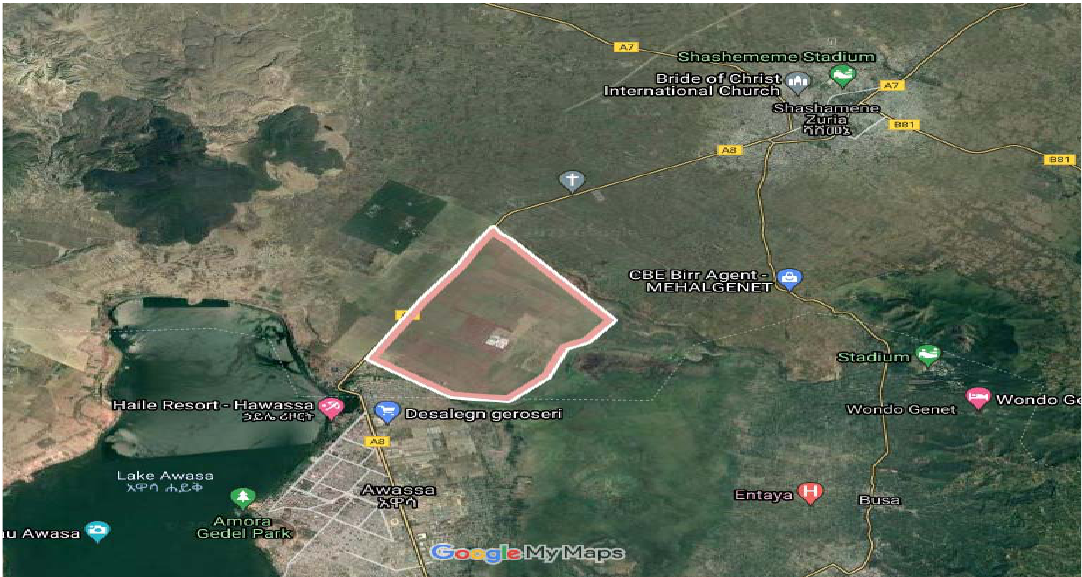
Figure 1. Rain ‐ fed and irrigated crop production of the Elfora Shalo–Melga farm. The farm grows a variety of crops, including maize, sorghum, and soybeans. Food crops include grains, such as corn, wheat, rice, and other types of crops (e.g., vegetables and fruits). (Source: Google Maps).